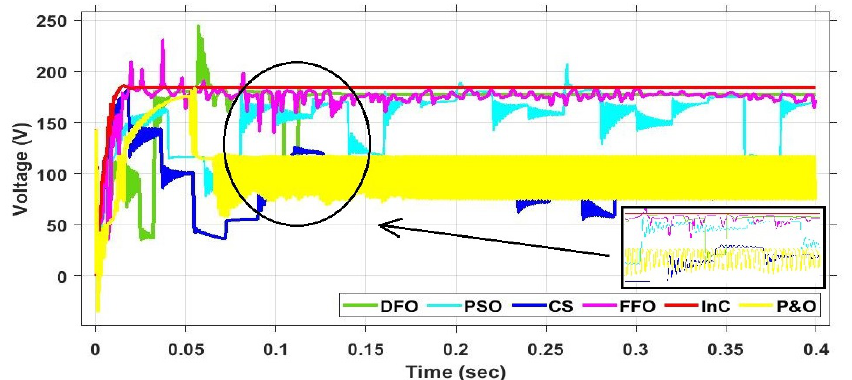
Figure 15. PS1 voltage comparison between all algorithms for centralized PV